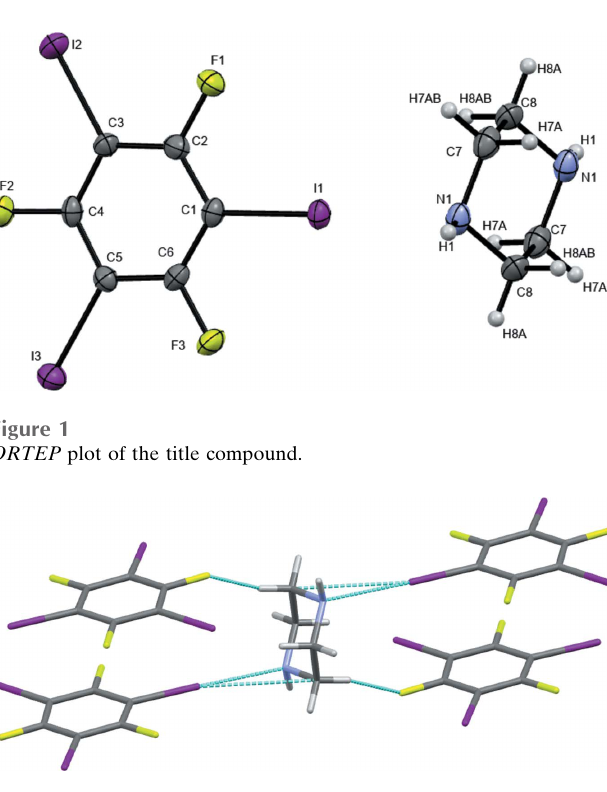
Figure 2 Detail of the X-ray crystal structure depicting a halogen bond between iodine and nitrogen, a short contact between iodine and carbon, and a short contact between hydrogen and fluorine. The other two iodine atoms on the aromatic ring do not engage in any halogen bonding or other close contacts.